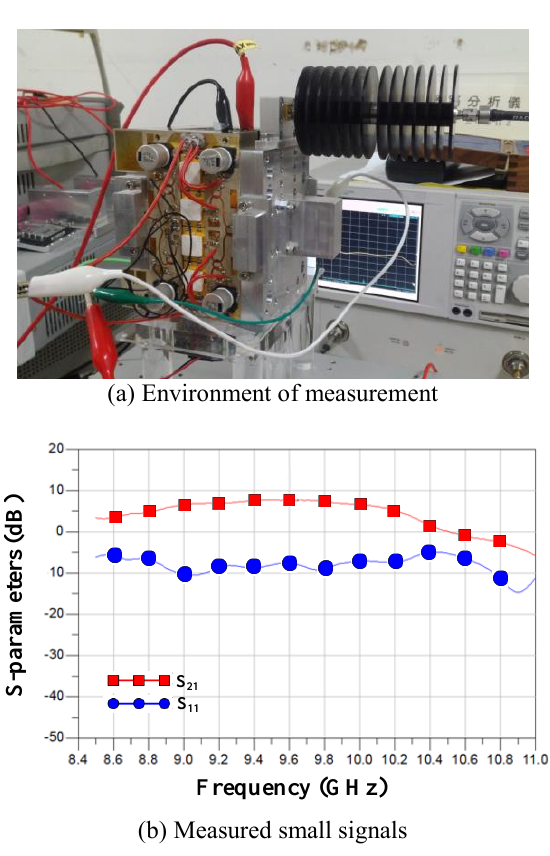
Figure 14: Measured small signal parameters of the proposed GaN high-power